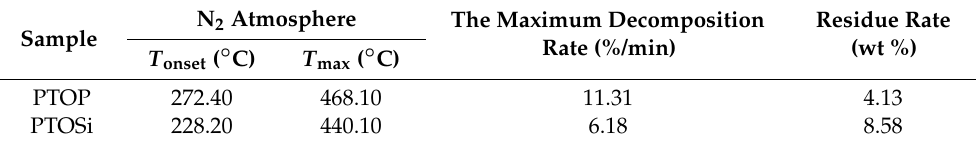
Figure 6. Thermogravimetric (TG) and DTG curves for PTOP and PTOSi. Table 3. The parameters of TG and DTG of PTOP and PTOSi.